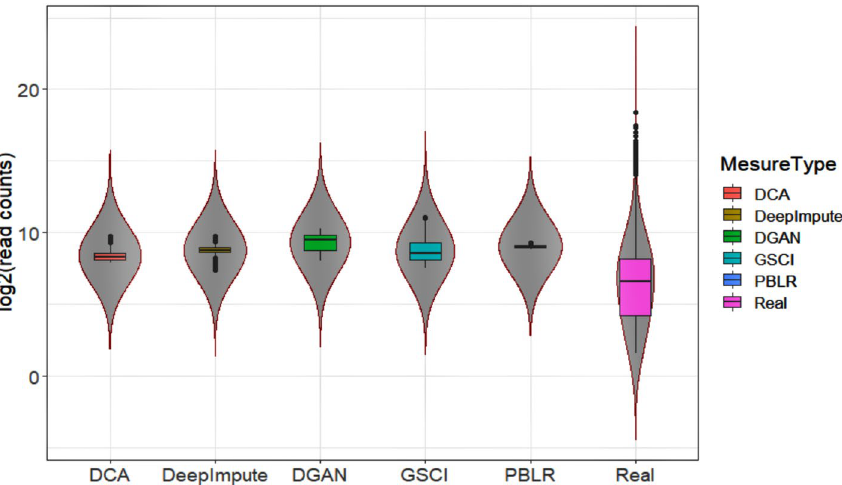
Figure 2. Violin plot depicting real and imputed data of Basile dataset attained from implementing all paralleled models in terms of log of coefficient variation computed for individual genes across the cells. The interquartile range is represented by the box, in addition the median is represented by horizontal line and whiskers demonstrate larger interquartile